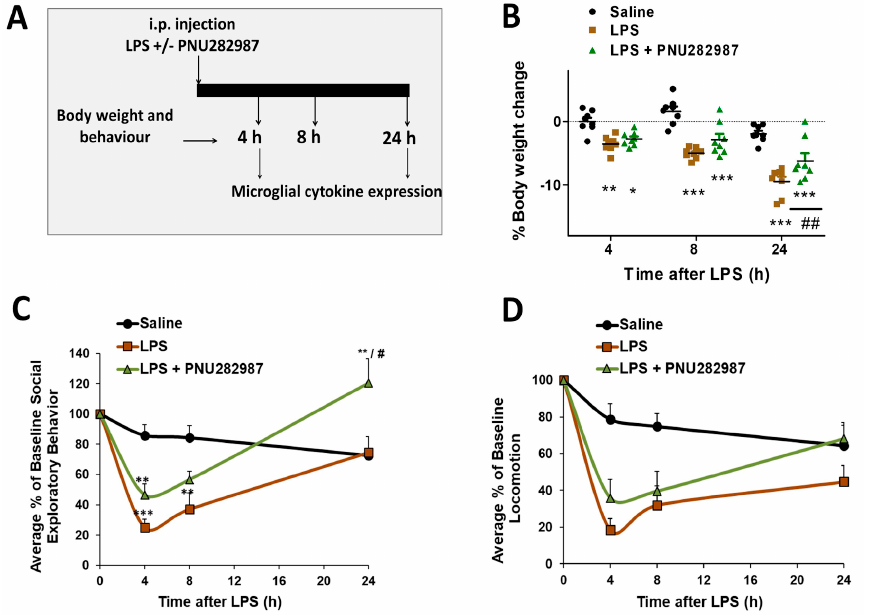
Figure 1. Activation of α 7 nAChR by co-administration of PNU282987 and lipopolysaccharide (LPS) via i.p. attenuates behavioral alterations associated with LPS challenge in adult mice. ( A ) The experimental protocol performed in adult Balb/c mice injected i.p. with LPS 0.33 ± 10 mg/kg PNU282987. ( B ) Body weight change, ( C ) locomotor activity and ( D ) social exploratory behavior; measured at 4, 8 and 24 h after injections (Saline, LPS, LPS + PNU282987). Data are represented as the mean and S.E.M (eight animals per group). Comparisons were made using Two-way ANOVA. * p < 0.05, ** p < 0.01, *** p < 0.001 vs. saline; # p < 0.05 ## p < 0.01 vs. LPS.